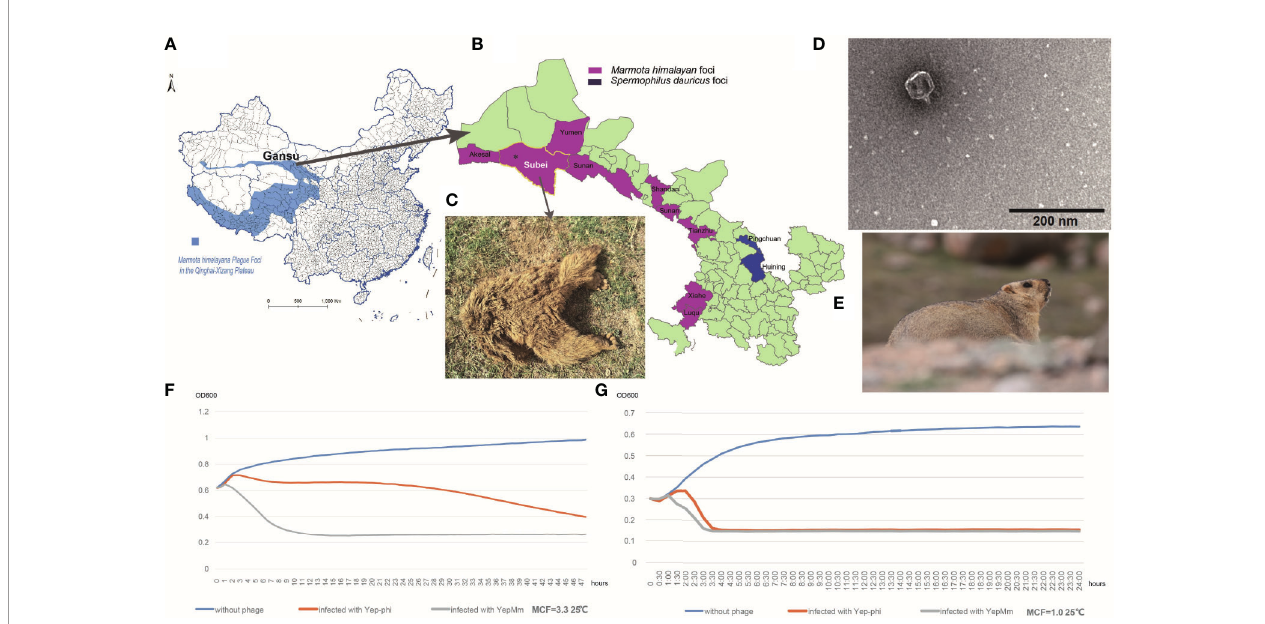
FIGURE 1 | Characteristics of the Y. pestis bacteriophage YepMm. (A) Marmota himalayana in a plague-area focus in Qinghai-Tibet plateau in China. (B) Marmota himalayana in a plague-area focus in Gansu Province, China. (C) The Marmota himalayana (who died of natural causes) from which we isolated a lytic Y. pestis bacteriophage: YepMm. (D) Electron microscopy of YepMm. (E) A healthy Marmota himalayana in a plague-focus area of the Qinghai-Tibet plateau. (F) Growth curves of Y. pestis EV76 at 25°C, with MCF = 3.3 in the initial culture. Approximately 3.0 ± 0.2 × 10 7 PFU of the bacteriophages YepMm and Yep-phi in 30 µl were mixed with 300 µl of the bacterial culture (MCF = 3.3), respectively, and allowed to incubate for 24 h at 25°C. Each group had three duplicates. The OD 600 value of each group was measured every 30 min. The blue line shows the growth curve of strains without bacteriophage infection. The orange line shows the growth curve of strains infected with the bacteriophage Yep-phi. The gray line shows the growth curve of strains infected with the bacteriophage YepMm. (G) Growth curves of Y. pestis EV76 at 25°C, with MCF = 1.0 in the initial culture. Approximately 3.0 ± 0.2 × 10 7 PFU of the bacteriophages YepMm and Yep-phi in 30 µl were mixed with 300 µl of the bacterial culture (MCF = 1.0), and incubated for 24 h at 25°C. Each group had three duplicates. The OD 600 of each group was measured every 30 min. The blue line shows the growth curve of strains without bacteriophage infection. The orange line shows the growth curve of strains infected with the bacteriophage Yep-phi. The gray line show the growths curve of strains infected with the bacteriophage